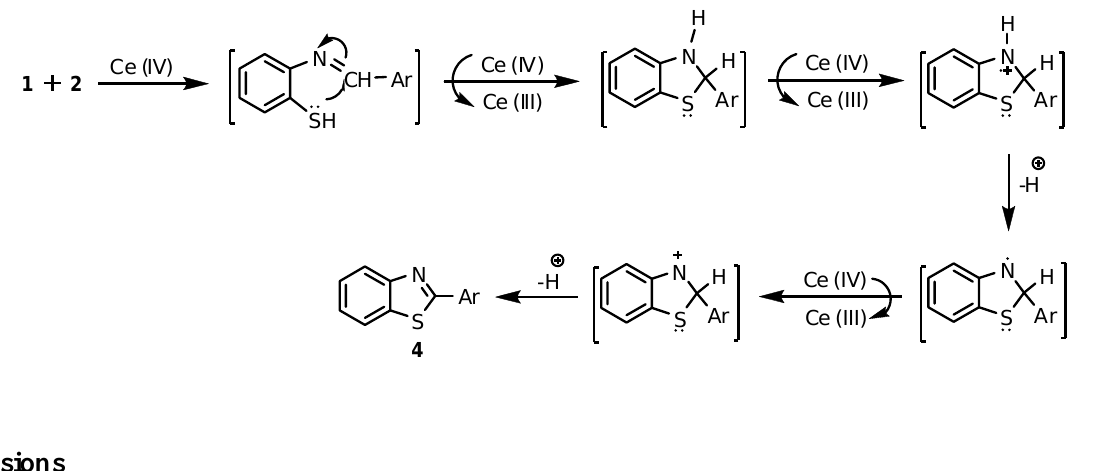
Figure 2 . A proposed mechanism for the formation of